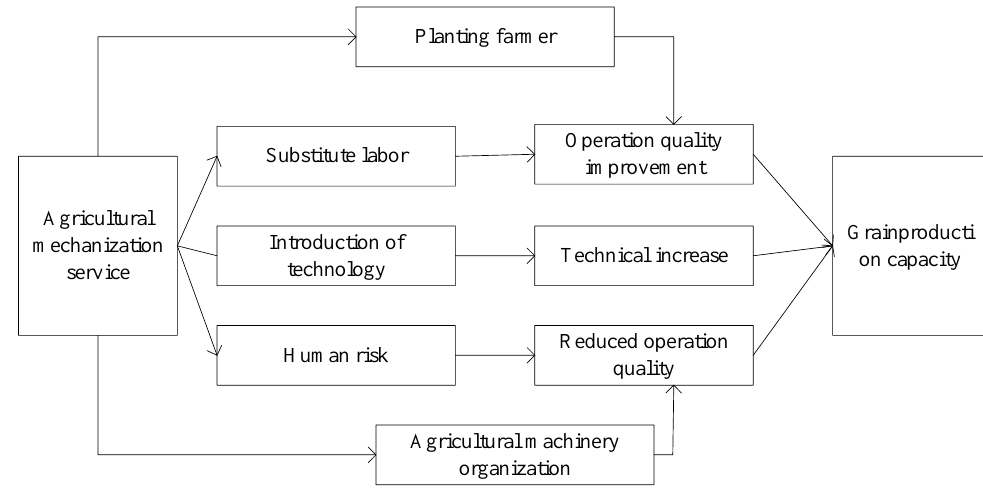
Figure 1. Impact mechanism of agricultural mechanization service on grain production capacity.